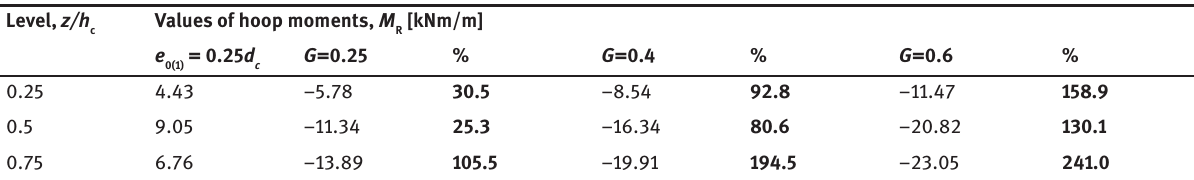
=10 m, calculated taking into account the c = 0.25 d 0(1) c